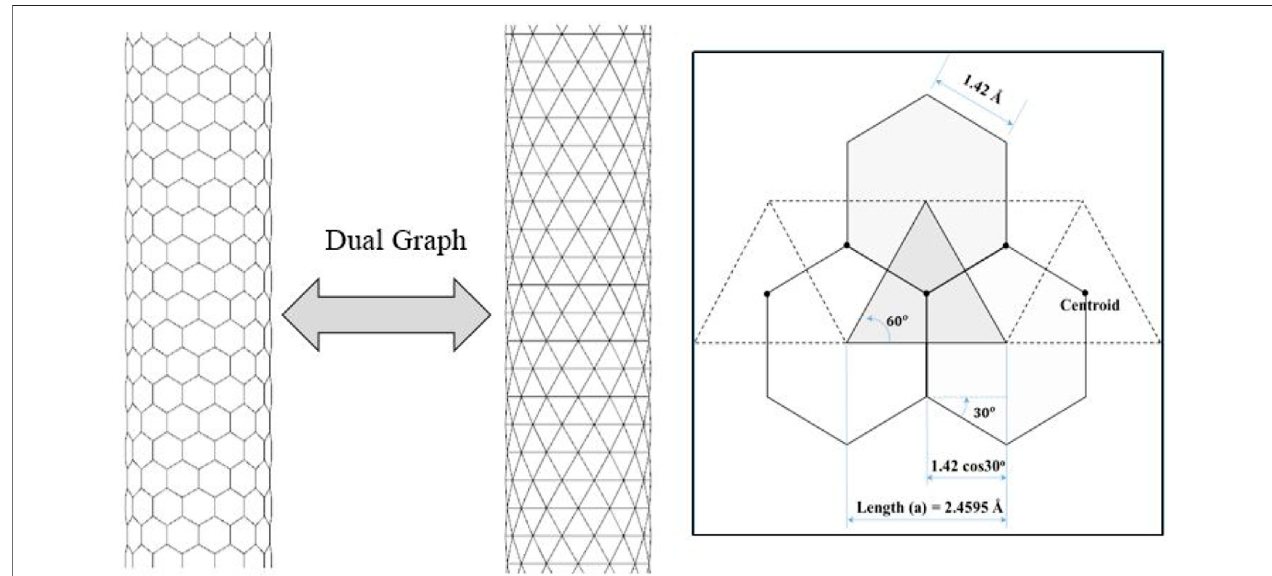
FIGURE 1 | Dual mesh representation of (14,0) SWCNT. The inset fi gure shows the determination of the length of the regular triangular mesh.